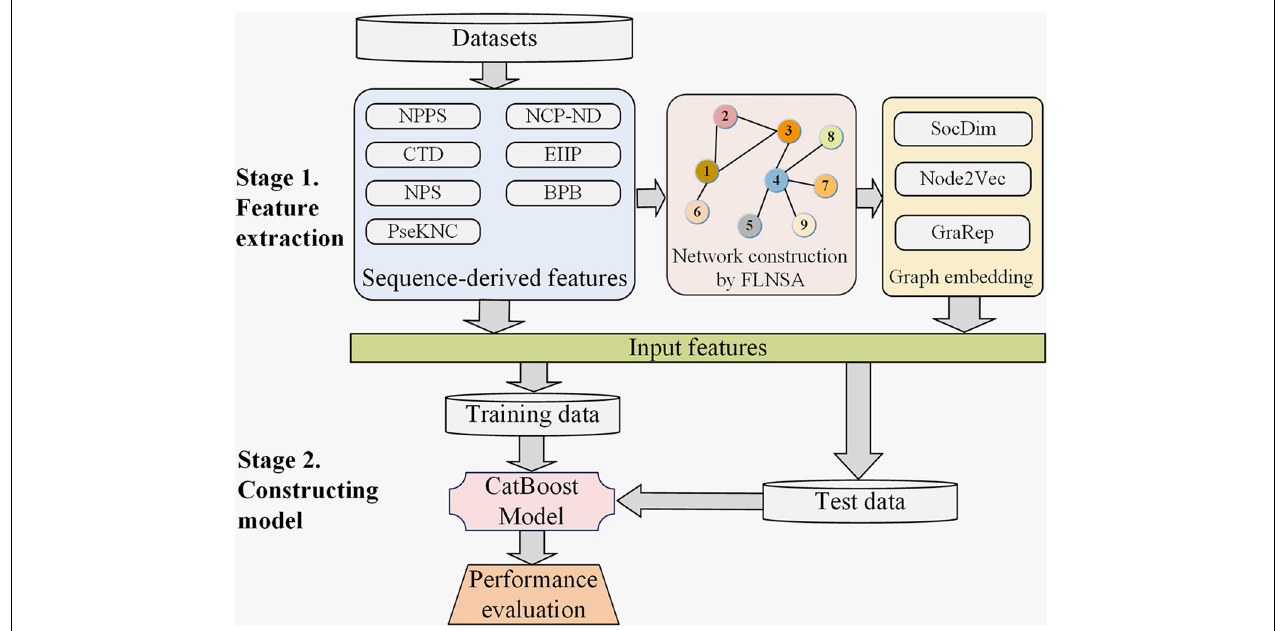
FIGURE 1 | The computational framework of our predictor m6AGE. There are two main stages in the construction of m6AGE. Stage 1. Sequence-derived features are extracted, and graph embeddings are learned. Sequence-derived feature encoding methods directly encode RNA sequences into numerical vectors, including CTD, NPS, PseKNC, NPPS, NCP-ND, EIIP, and BPB feature encoding method. All the sequences are mapped to nodes of a network, and then their graph embeddings (SocDim, Node2Vec, and GraRep) are learned in an unsupervised manner. At last, the sequence features and graph embeddings are merged as